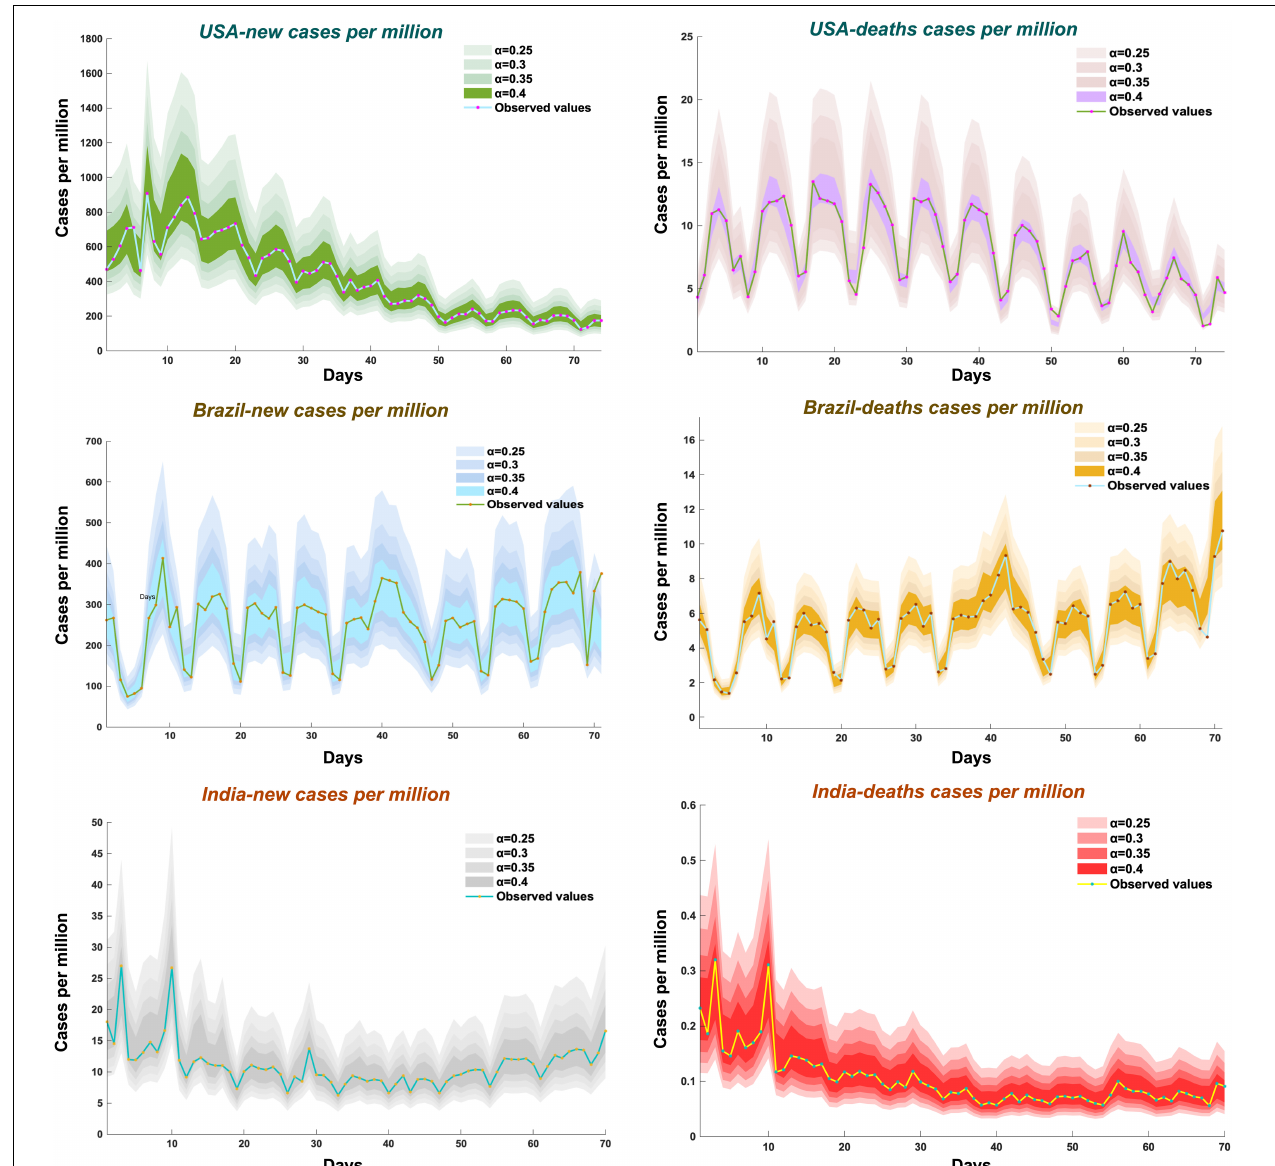
FIGURE 4 | Interval prediction results of the proposed model with different significance levels.